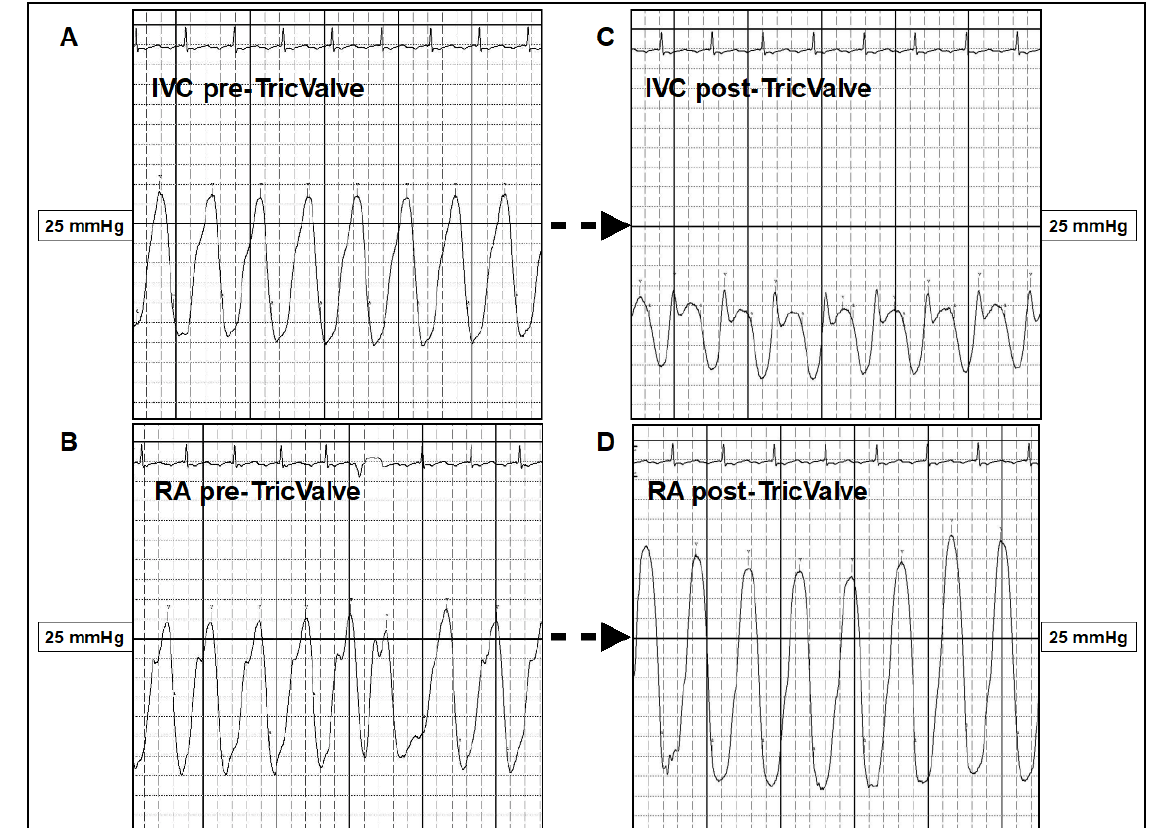
Figure 6. Ventricularization of the RA following TricValve ® implantation. ( A and B ) Baseline, IVC pressure curve is 18 mmHg (and v-wave is 28 mmHg) and in the RA is 17 mmHg (V-wave is 27 mmHg). ( C and D ) Following TricValve ® implantation there is a clear decrease of the caval pressures with a corresponding change in the curve morphology ( C ). As a consequence of the acute afterload increase, there is an increase in the RA pressure with ventricularization of the curve morphology in the acute phase ( D ). At chronic phase, RA pressure trends to decrease. IVC: Inferior Vena Cava pressure curve. RA: Right Atrium pressure